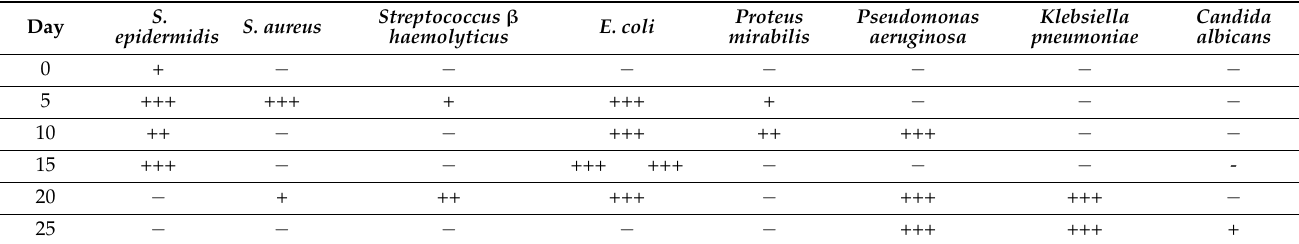
to their complete absence in the culture results, on days 20 and 25 of the experiment. On 15 day of experiment, two colonies of Escherichia coli were observed (Table 3). Table 3. Identification of pathogens grown from the wound treated with the 1% propolis